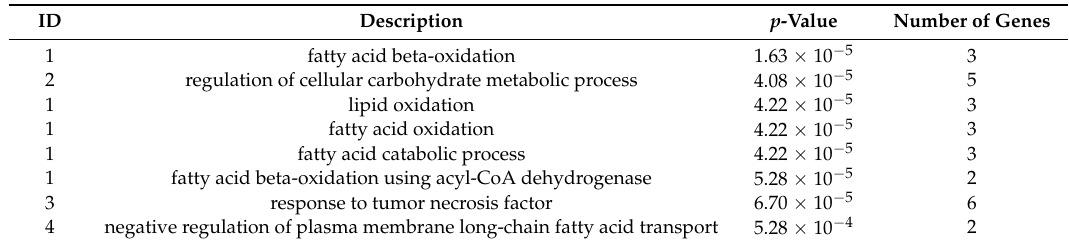
Table 3. GO enrichment test results.